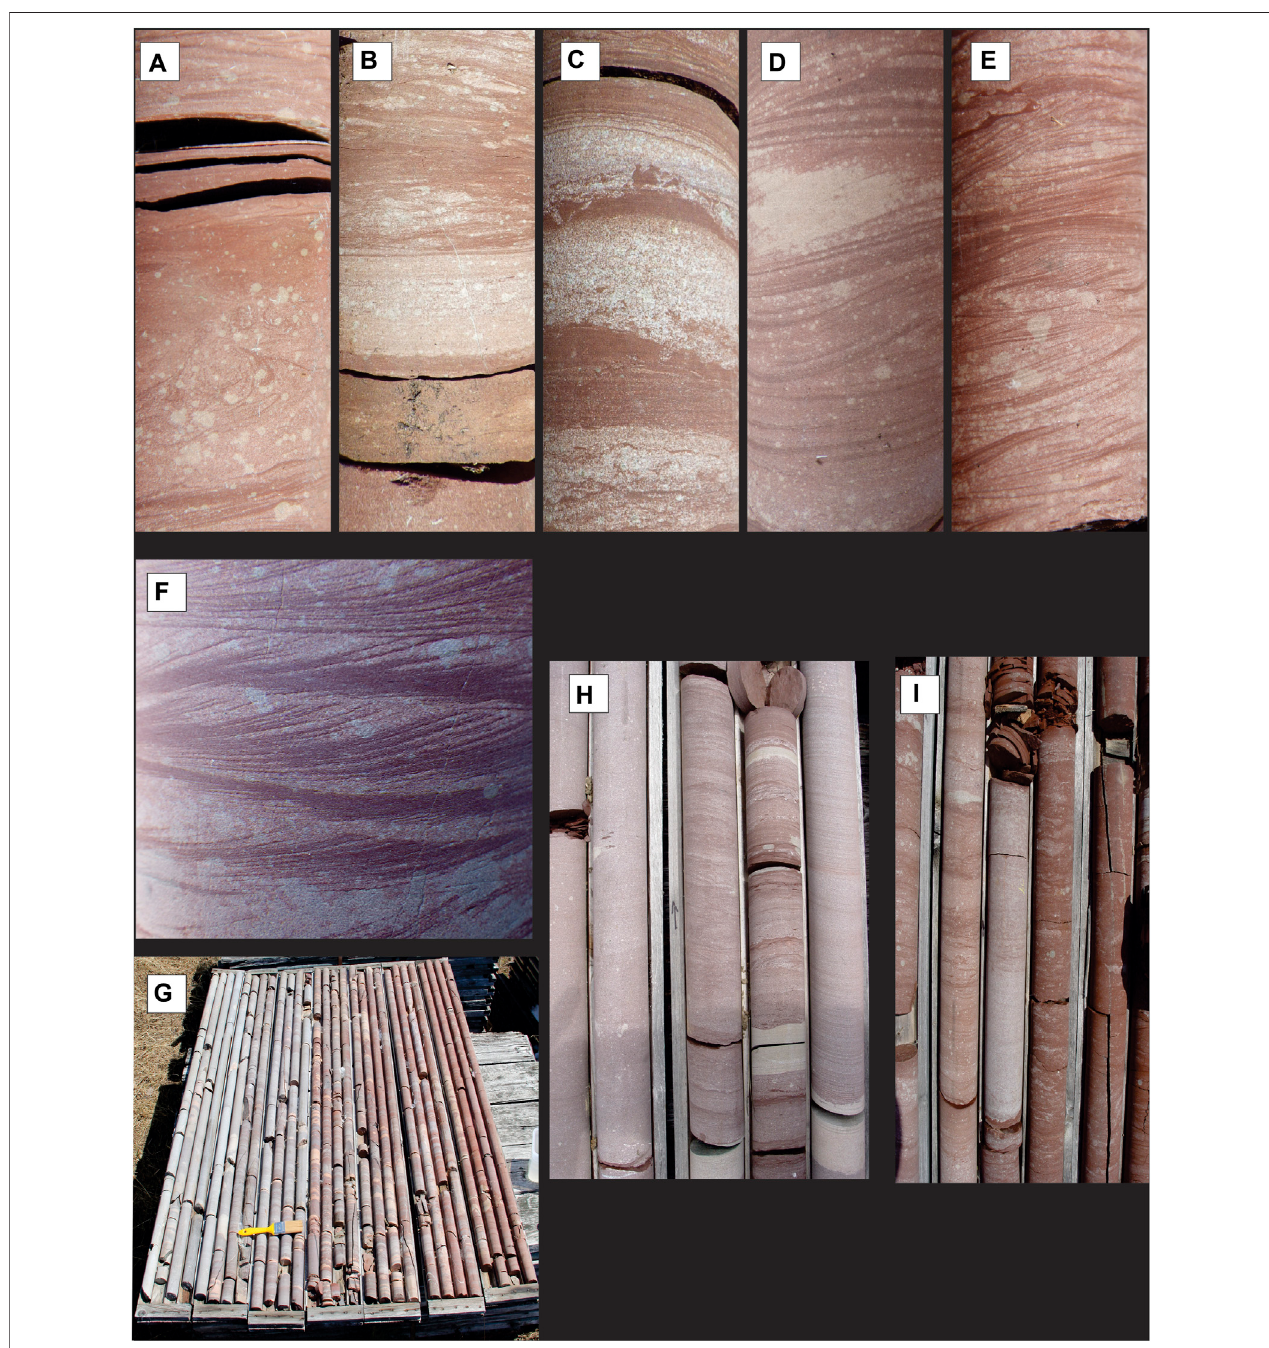
FIGURE 7 | Lithofacies that are common in the upper portion of the two large-scale coarsening- and thickening-upward successions containing parasequences. Core is 4.5 cm wide. (A) Graded, massive and parallel laminated, very fi ne-grained sandstone and siltstone layers with small-scale erosive scouring and contorted laminae, probably due to dewatering. (B) A graded fi ne-grained sandstone layer erosively truncated and overlain by wispy layering. (C) Massive and parallel laminated medium-grained, graded sandstone layers, with small clayey-silt rip-ups, interlayered with clayey-silt; some of which are also graded. (D) Small-scale hummocky cross-strati fi cation overlain by ripple lamination in medium-grained sandstone. (E) Wave ripple laminated, medium-grained sandstone with silt and clayey-silt fl asers. (F) Current ripple laminated, fi ne-grained sandstone with clayey-silt fl asers. (G) Coarsening upwards sequence near the top of the upper coarsening- and thickening- upwardsuccession.Theamount of fi ne-andmedium-grained sandstone layersincreaseupward until theydominate. Bottom isat upperright; top atlowerleft. (H) Core from the upper portion of the second coarsening- and thickening-upward succession. Cross-strati fi ed, medium-grained sandstones, on right, separated from massive, medium-grained sandstones, on left, by thinly layered siltstones and fi ne-grained sandstones. Bottom is lower left and top is upper right. (I) Core from the fl oodplain assemblage where lensoid layered, very fi ne-grained sandstones and siltstones are overlain by a sharp-sided, medium-grained crevasse splay deposit with a clay infused top, which in turn is succeeded by parallel laminated shale and clayey-siltstone. Bottom is lower left and top is upper right.